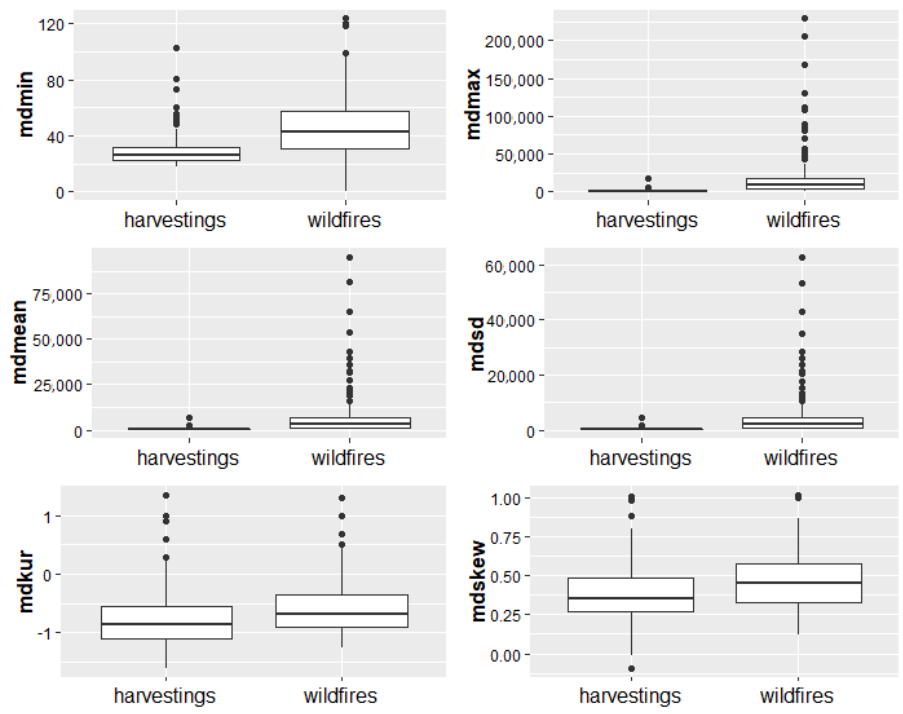
Figure 6. Paired boxplots of the metrics calculated related to how the points in each cluster are distributed in relation to one another. Boxplots are median based.